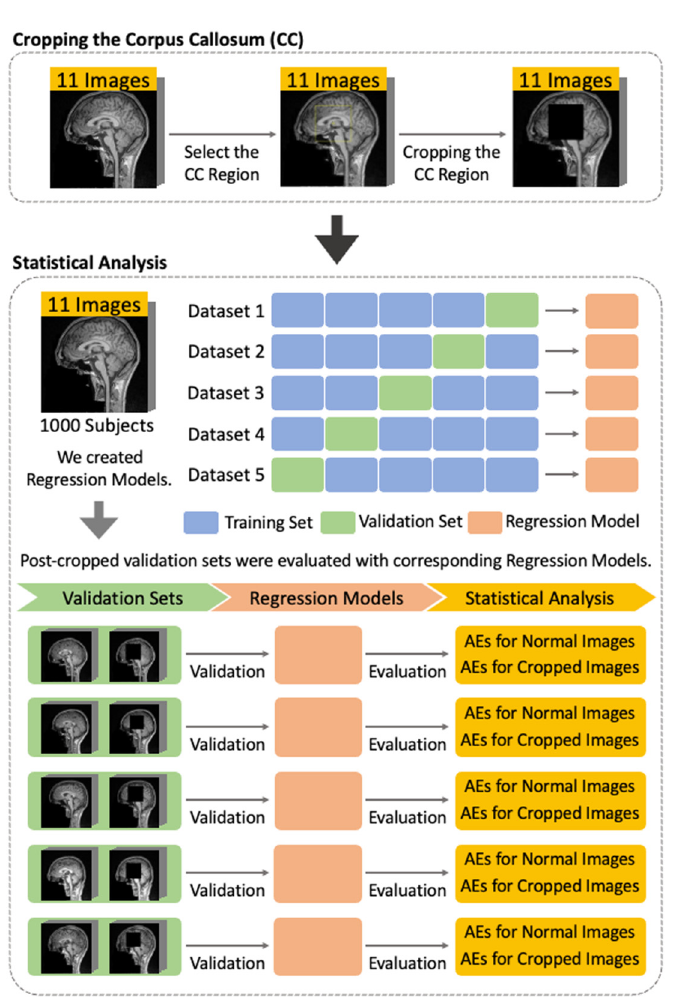
Figure 4. The process of the statistical analysis on the accuracy of age estimation before and after the removal of the corpus callosum (CC) region.